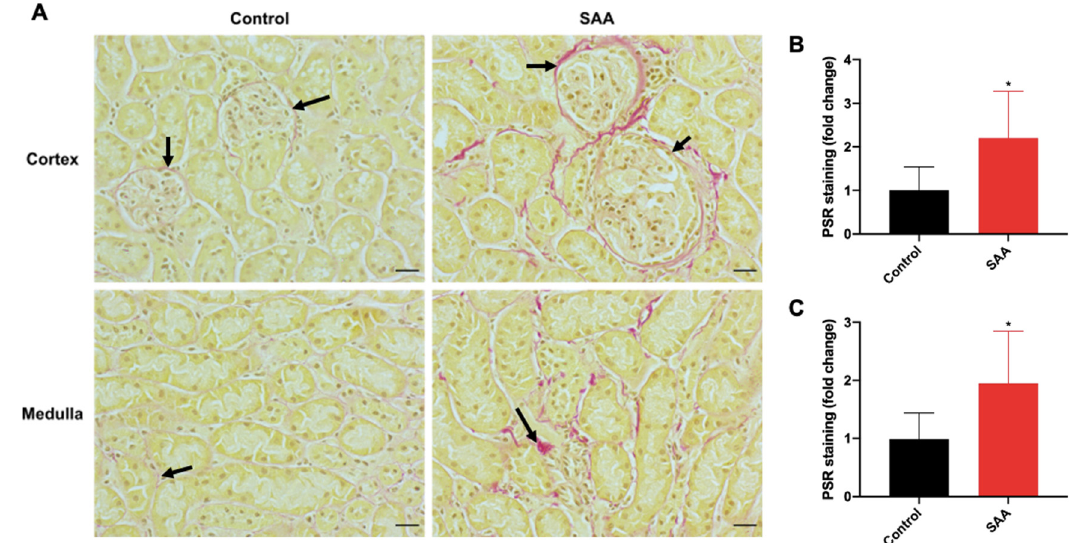
Figure 9. SAA administration causes long-term fibrotic changes in kidneys. ( A ) Male ApoE − / − mice were randomly allocated to vehicle control (administered 100 µL PBS every 3 days for 2 weeks) and the SAA group (administered 12 µg SAA protein every 3 days for 2 weeks). Kidney tissue was harvested 14 weeks after cessation of treatment and fixed in situ before embedding and sectioning (5 µm). Renal sections were dewaxed then rehydrated before staining with haematoxylin and picrosirius red (PSR) solution. Renal fibrosis was assessed using the PSR stain for collagen. Slides were visualised using an Axio Scope.A1 light microscope at 40× magnification (scale bar = 20 µm); images are representative of at least 4 fields of view for each sample. For all images shown, nuclei are stained with haematoxylin (brown), and collagen with PSR (red). Black arrows indicate PSR staining localised to the parietal epithelial cells lining the outer surface of Bowman’s space and the interstitial spaces in the SAA group. Representative images show PSR+ staining in renal cortical and medullary fields from n = 8 (control), n = 6 (SAA). PSR staining in the ( B ) cortical and ( C ) medullary regions were quantified using thresholding tools for each field of view and averaged for each sample. Data shown as relative mean ± SD. * Different to the control group; p < 0.05.